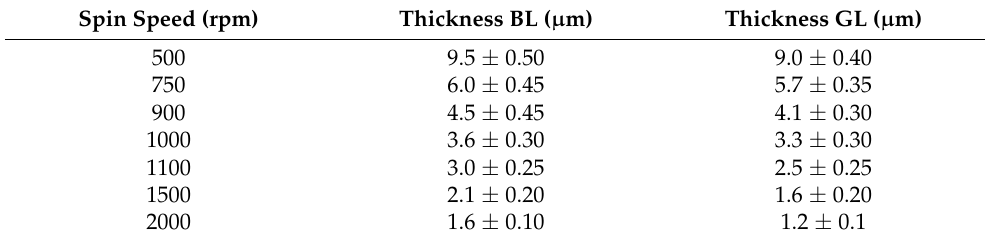
Figure 5. Refractive index vs. UV curing time for materials A–D ( A ) and coating thickness vs. UV exposure time for all materials A–D ( B ). Table 2. Thickness versus deposition speed for materials BL and